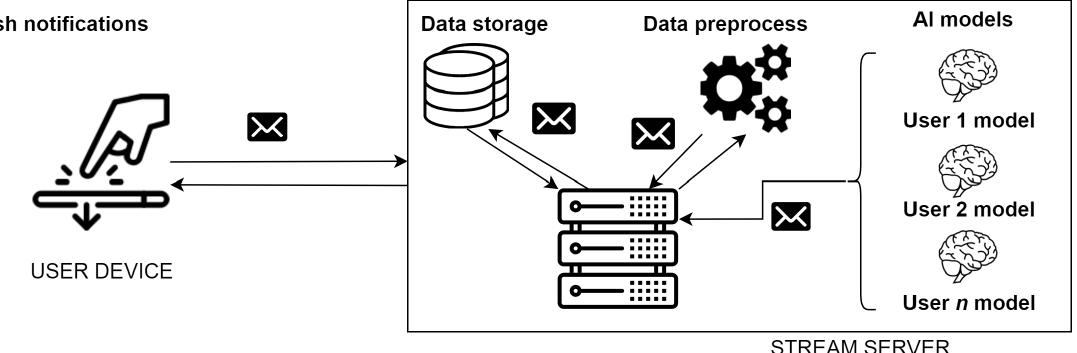
Figure 1. Authentication scheme for streaming